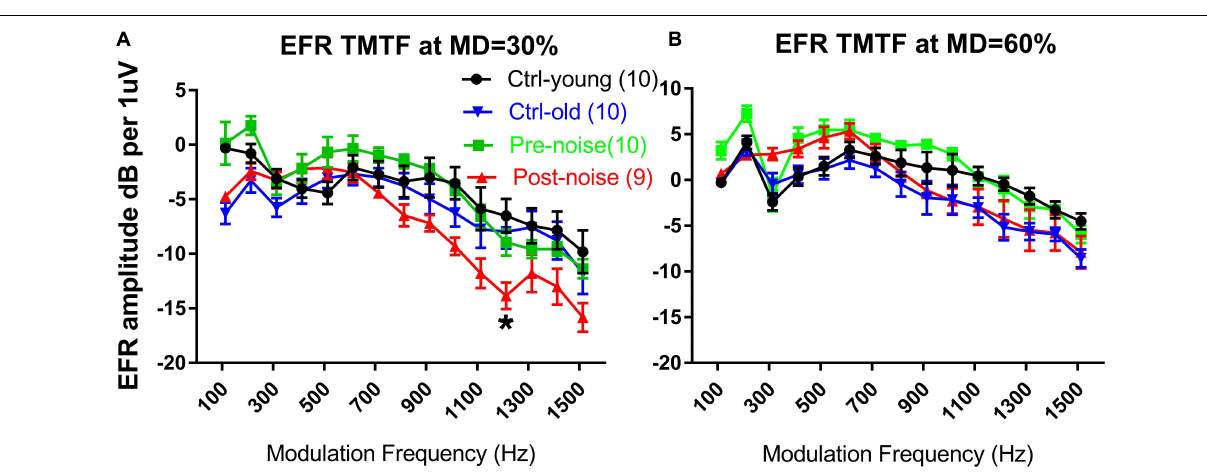
FIGURE 4 | The impact of age and noise on EFR TMTFs measured in response to AM at 30% (A) and 60% (B) MD. The post-noise TMFT curve obtained with 30% MD diverged from the pre-noise and ctrl-old TMTFs. A significant difference in EFR amplitude was seen between the ctrl-old and the post-noise TMTF at 1213 Hz MF. * p <